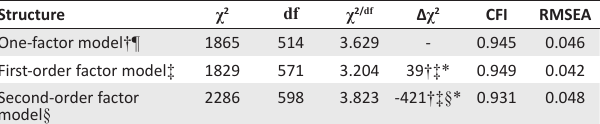
TABLE 6: Comparison of an a priori nine-factor structure (the adapted factor structure of the Human Resource Practices Perceptions Questionnaire).